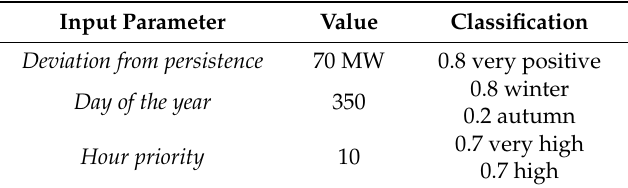
Table 1. Input values used for the rules extraction